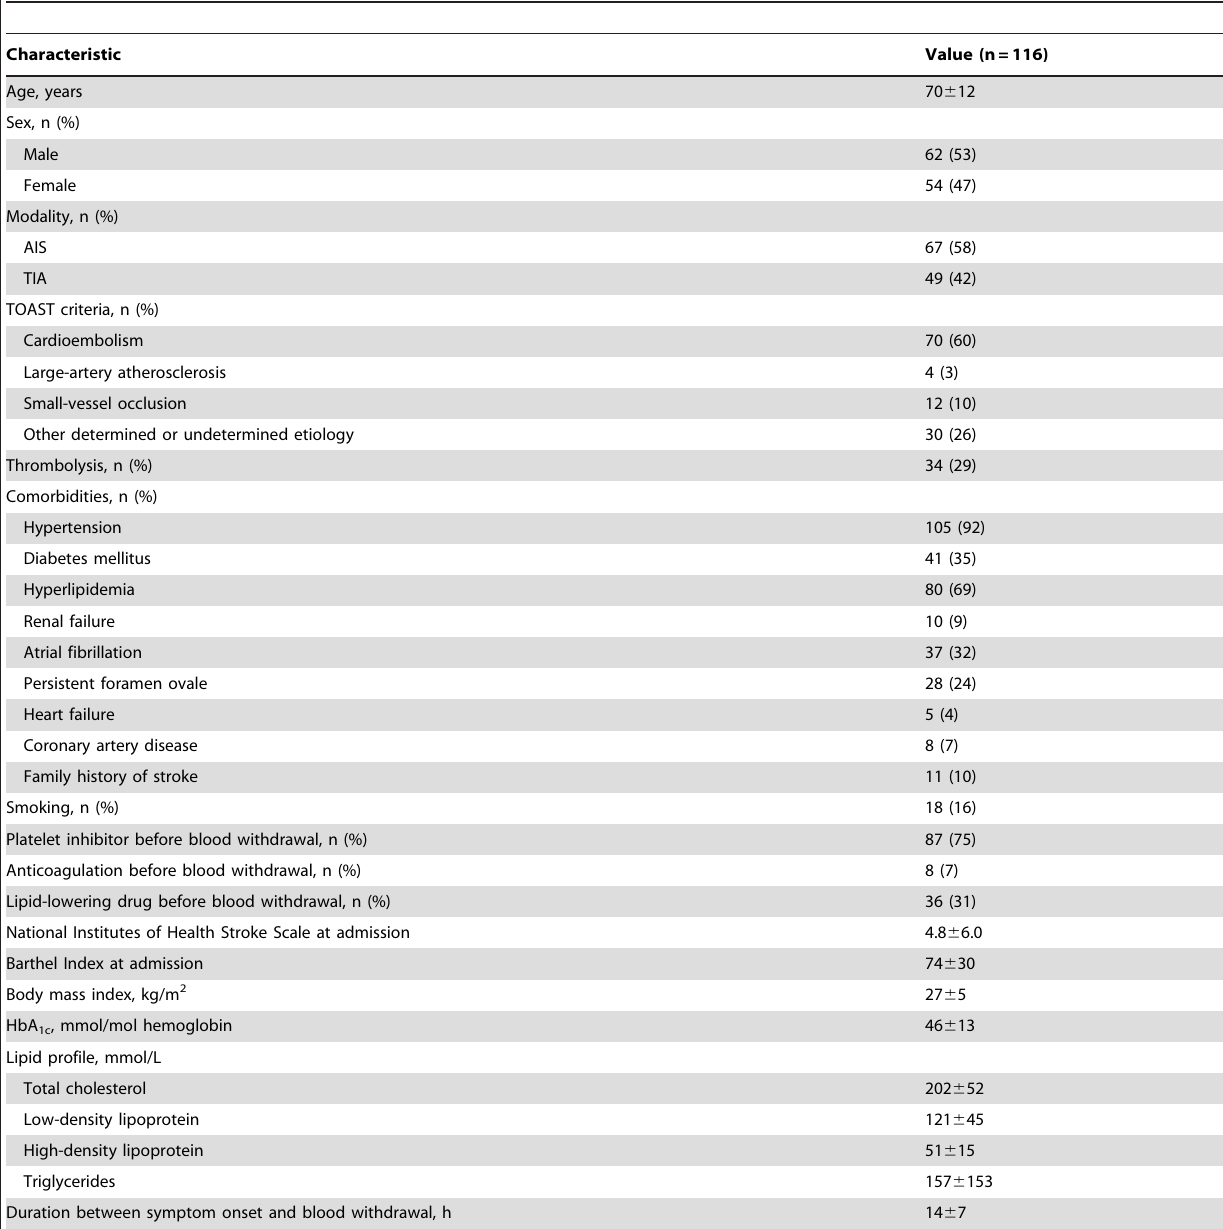
Table 1. Baseline characteristics of acute ischemic stroke (AIS)/transitory ischemic attack (TIA)